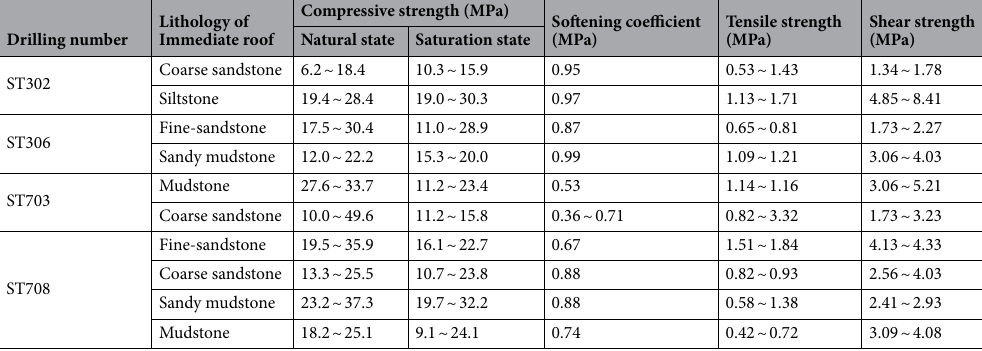
Table 1. The rock mechanics testing results of immediate roof for No. 8 seam.